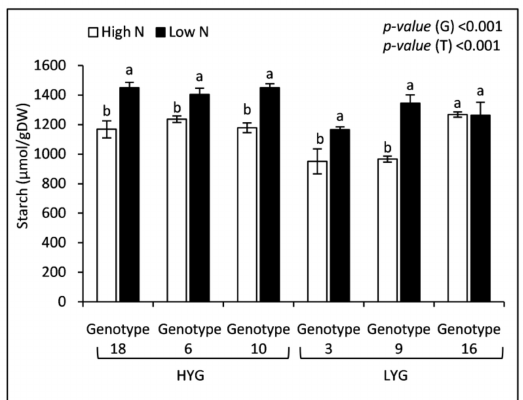
Figure 2. Grain starch concentration of 6 wheat genotypes fertilized by two nitrogen levels (High and Low). Data correspond to the means ± standard error (n = 4). For each genotype, letters indicate significant di ff erences between the two treatment. At p < 0.5. p -values corresponds to two-way ANOVA analysis. HYG: High-yielding genotypes, LYG: Low-yielding genotypes, G: Genotype, T: